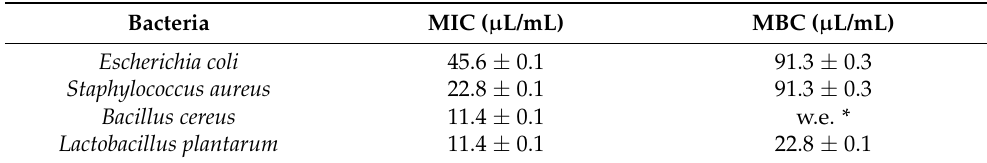
Table 5. MICs and MBCs results of Crithmum maritimum L. essential oil. All the determinations were performed in triplicate and the results expressed in mean ±